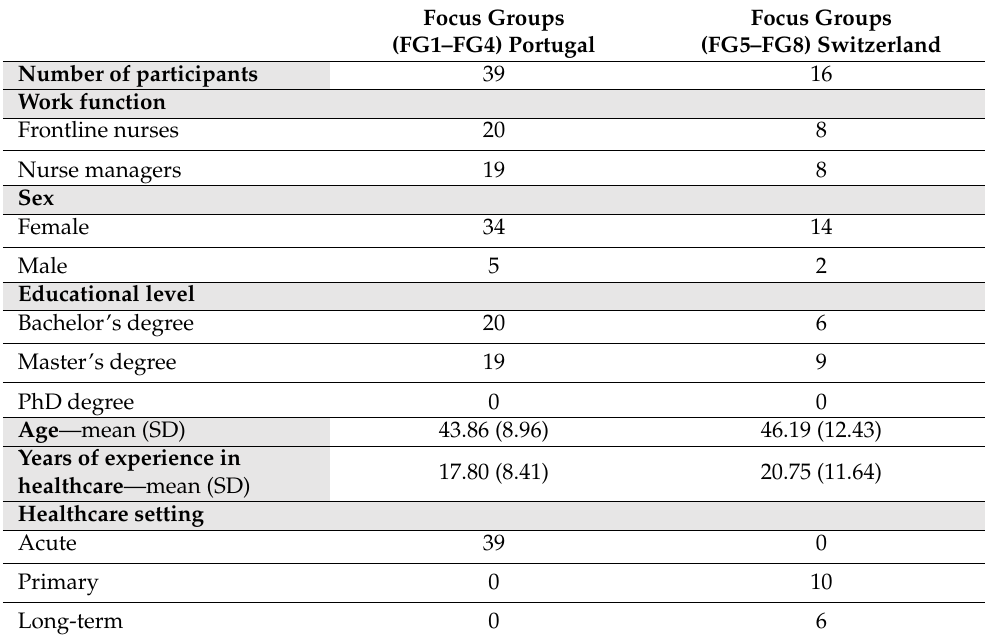
Table 2. Sociodemographic and professional characteristics of the participants ( n =